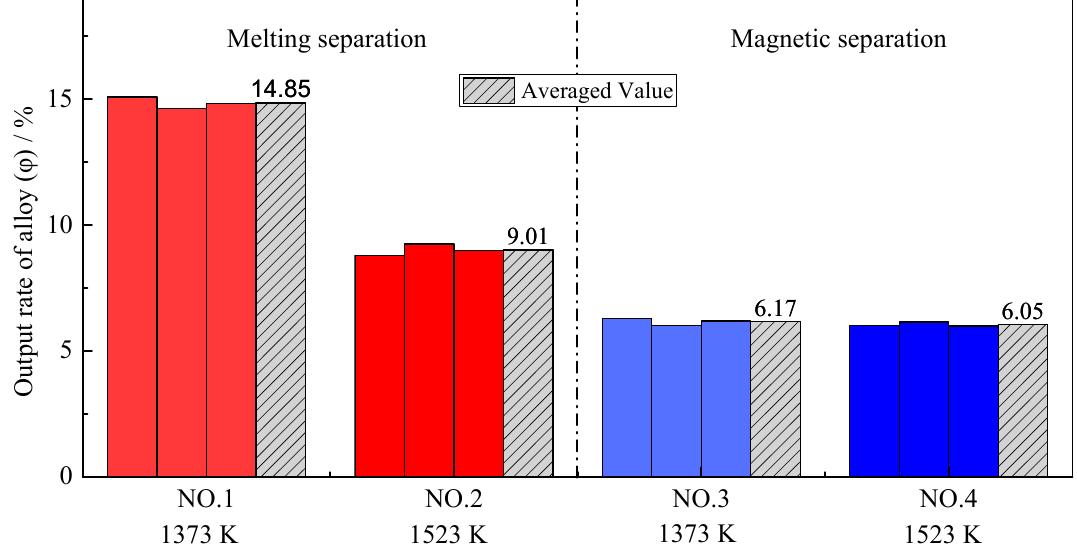
Figure 4. Output yield of alloy with different pre-reduction temperatures and different separation processes.